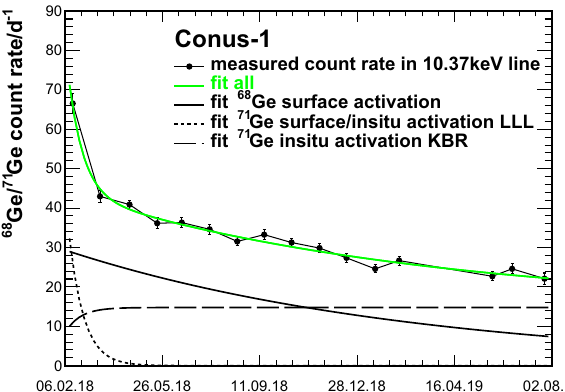
Fig. 11 The decayofthe count rateofthe10.37keV lineisobservedin thedatainmonthlybins,exemplaryforC1.Therearethreecontributions to the count rate: the decay of 68 Ge (T 1 / 2 = 271.0d) induced at the Earth’s surface, the decay of 71 Ge (T 1 / 2 = 11.4d) induced at the Earth’s surfaceandatLLL,andtheinsituactivationof 71 GewithintheCONUS shield at KBR. Data are fitted successfully with the respective